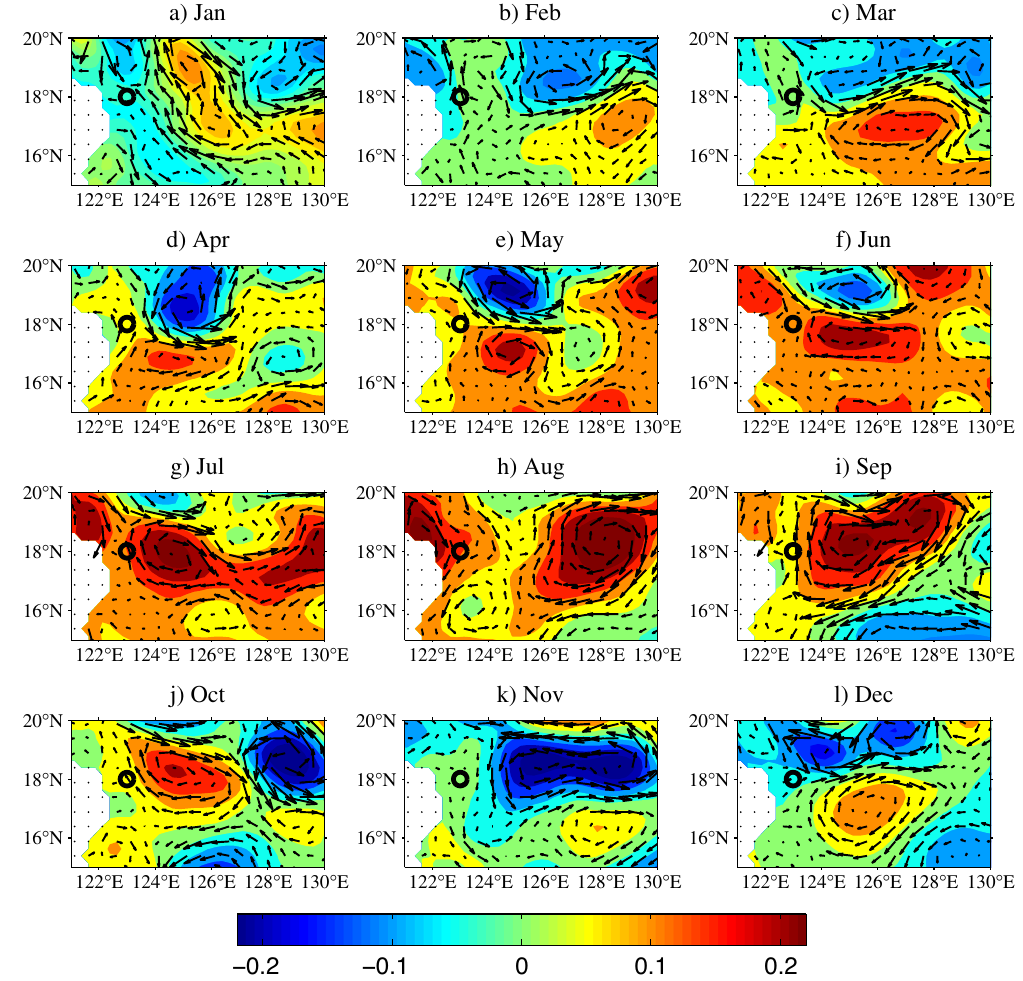
Figure 7. SSHa (m) from satellite altimeter data in the origin region of the KC in ( a ) January, ( b ) February, ( c ) March, ( d ) April, ( e ) May, ( f ) June, ( g ) July, ( h ) August, ( i ) September, ( j ) October, ( k ) November, and ( l ) December 2018. Black circles denote the mooring deployed at 123° E, 18° N. The geostrophic current anomalies are calculated from satellite altimetry (http:// www. marine. coper nicus. eu). Figures are plotted using MATLAB R2012b (http:// www. mathw orks.